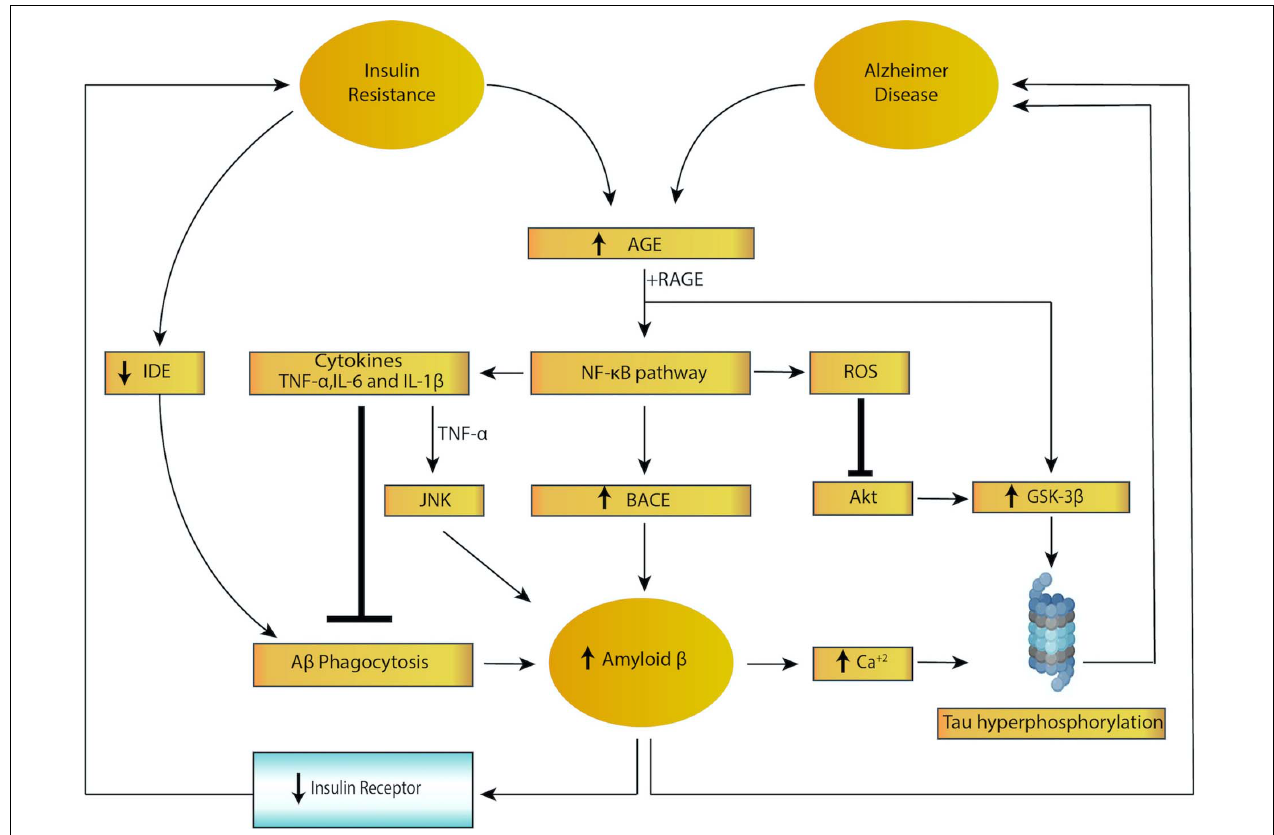
FIGURE 1 | Feed forward loop of insulin resistance and Alzheimer disease. Both insulin resistance and Alzheimer disease lead to activation of nuclear factor kappa B (NF- κ B), increased cytokine secretion and increased reactive oxygen species (ROS) levels, triggering increased amyloid beta (amyloid β ) and tau hyperphosphorylation. In addition, insulin resistance lowers levels of insulin degrading enzyme (IDE), resulting in impaired amyloid β phagocytosis. Higher levels of amyloid β , in turn, leads to decreased expression of the insulin receptor, which results in insulin resistance, creating a vicious